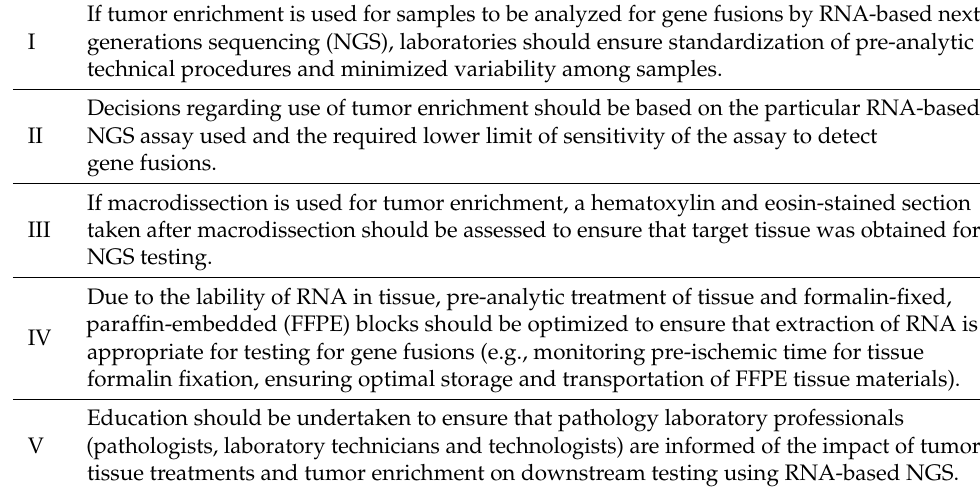
Table 1. Summary of pre-analytical recommendations to optimize RNA-based NGS for gene fusion